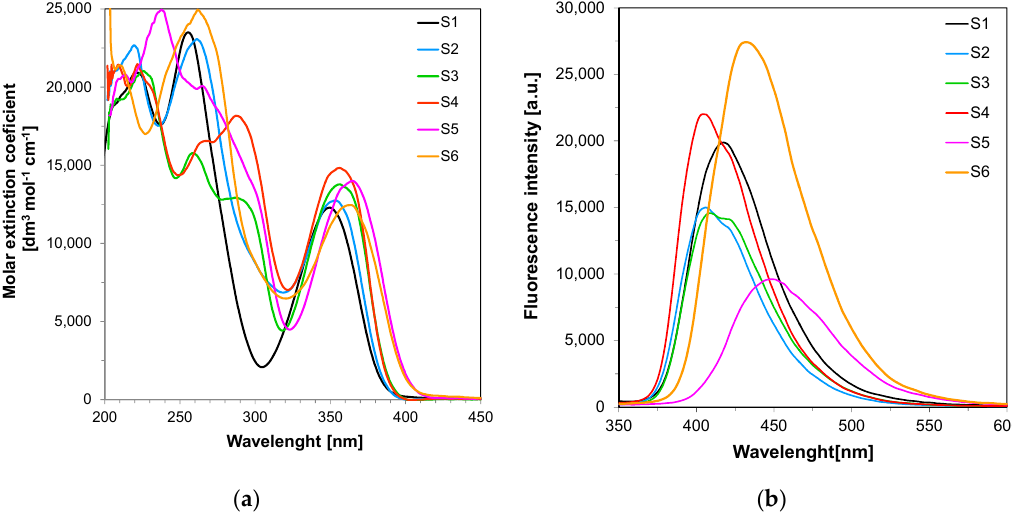
Figure 1. Spectroscopic properties of 2-amino-4,6-diphenyl-pyridine-3-carbonitrile derivatives: ( a ) UV-visible absorption spectra of the 2-amino-4,6-diphenyl-pyridine-3-carbonitrile derivatives in acetonitrile; ( b ) Fluorescence spectra of the 2-amino-4,6-diphenyl-pyridine-3-carbonitrile derivatives in acetonitrile in extinction 320 nm and integration time 1 s. Table 2. Spectral characteristics of the 2-amino-4,6-diphenyl-pyridine-3-carbonitrile derivatives studied.